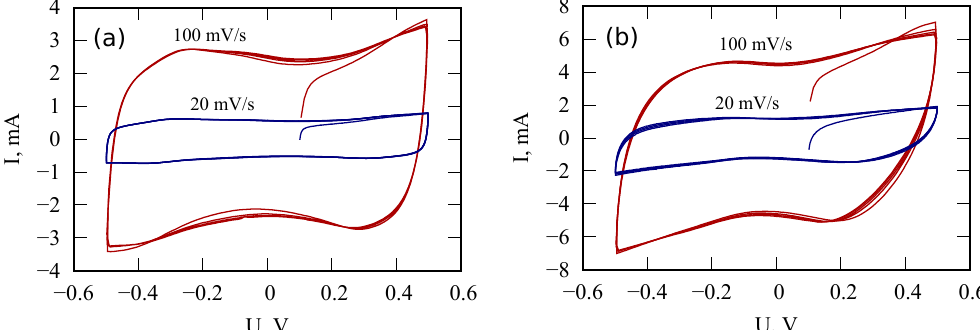
Figure 6. Cyclic voltammograms of PANI/VA-MWNT supercapacitors with one ( a ) and two ( b ) PANI layers. Scan rates are 20 and 100